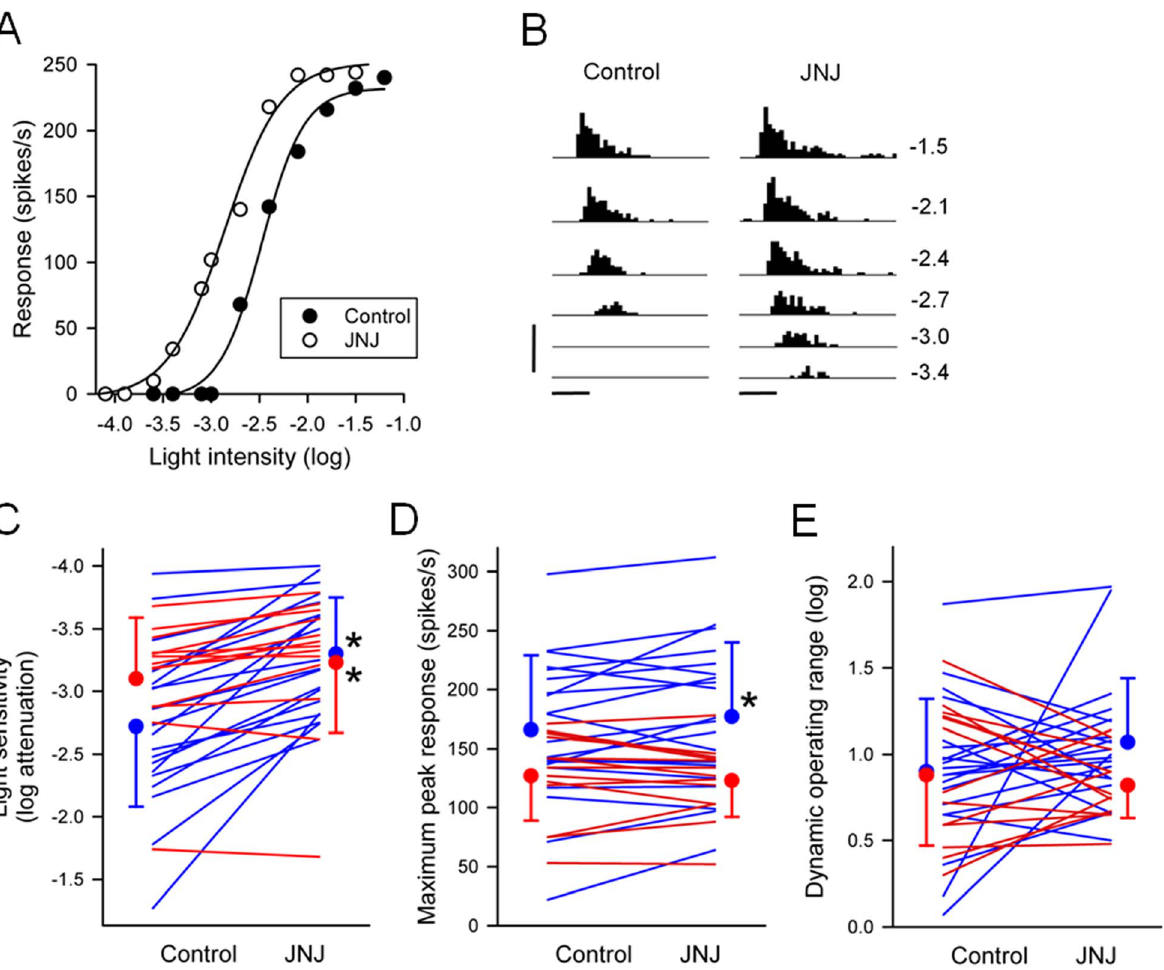
Figure 1. Effects of JNJ16259685 on light responses of P23H rat RGCs. ( A ) Intensity-response curves from an ON-center RGC, taken before and during application of JNJ16259685 (0.5 m M) to the bathing solution. The abscissa is labeled as log-unit attenuation in stimulus intensity from the maximum (8.5 6 10 17 photons/cm 2 /s). ( B ) Post-stimulus time histograms (10-ms bin width) of spike responses from the same RGC at six different light intensities. The values on the right are the number of log units of attenuation. Timing and duration (100 ms) of the light stimuli are indicated by the horizontal bars at the bottom. Vertical bar, 500 spikes/s. JNJ16259685-induced change in ( C ) light sensitivity, ( D ) maximum peak response, and ( E ) dynamic operating range of P23H rat RGCs (n=33). Individual ON-center RGCs (n=20) and OFF-center RGCs (n=13) are connected by blue and red lines, respectively. Each circle and vertical bar represents the mean and standard deviation of the mean. Asterisk indicates significantly different from control (P ,